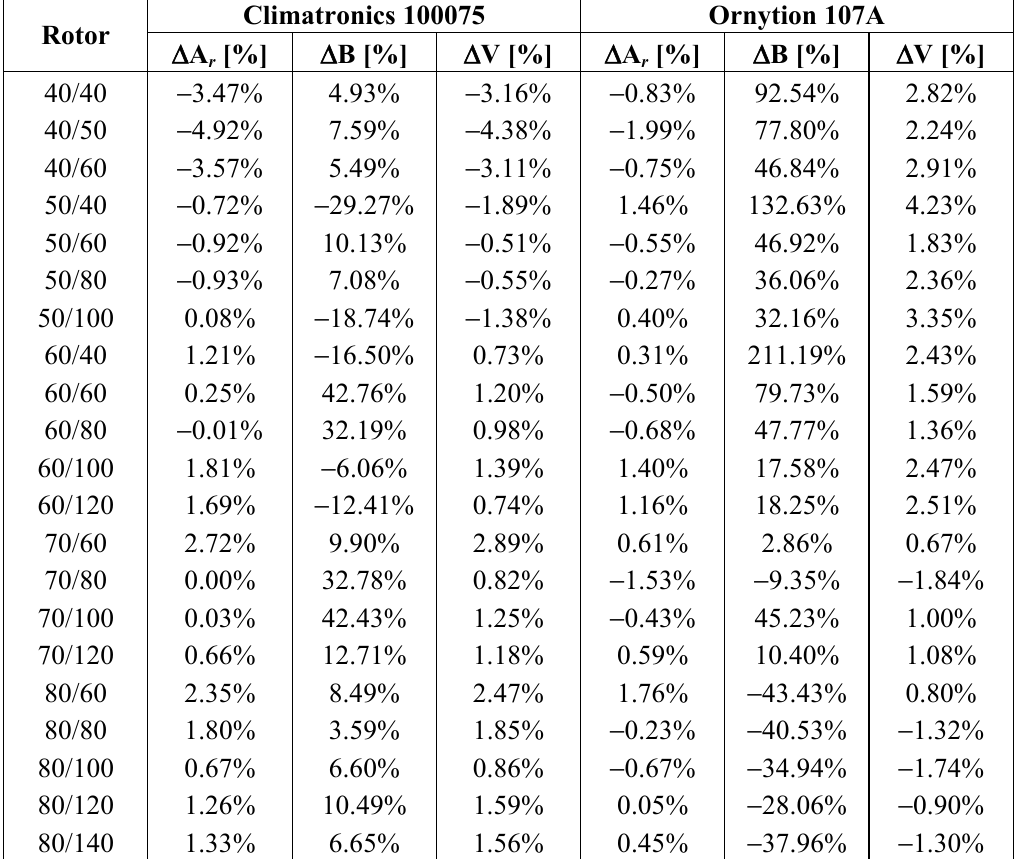
Table 4. Percentage variations of the anemometer transfer function slope and offset, A B, between the measured values and the estimated ones (based on the geometry parameters, Equations (20) and (22). The measured wind speed variations at V = 7 m·s also included in the